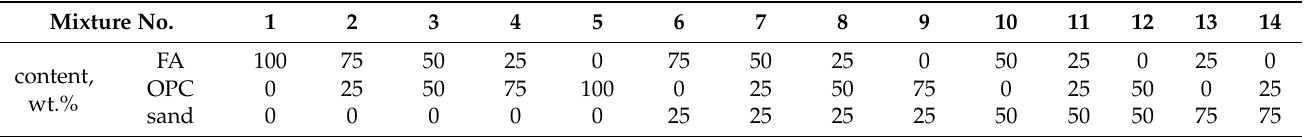
Table 2. Fly ash (FA)—ordinary Portland cement (OPC) and sand mixtures (proportion of compounds in wt.%). Mixture No. content,